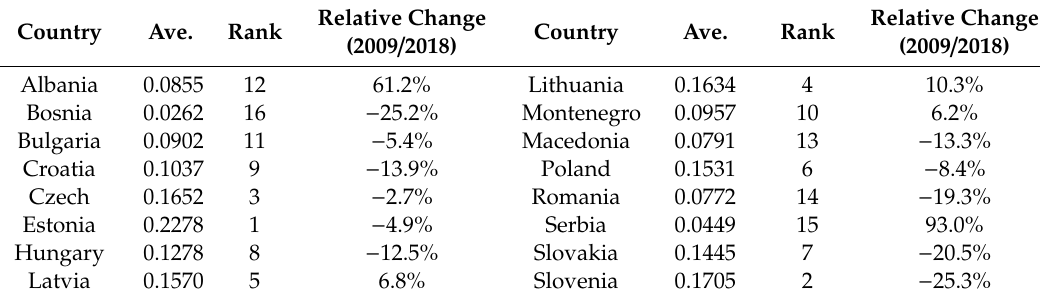
Figure 4. Evaluation results of political climate in CEE countries from 2009 to 2018. Table 6. Average evaluation results of political climate in CEE